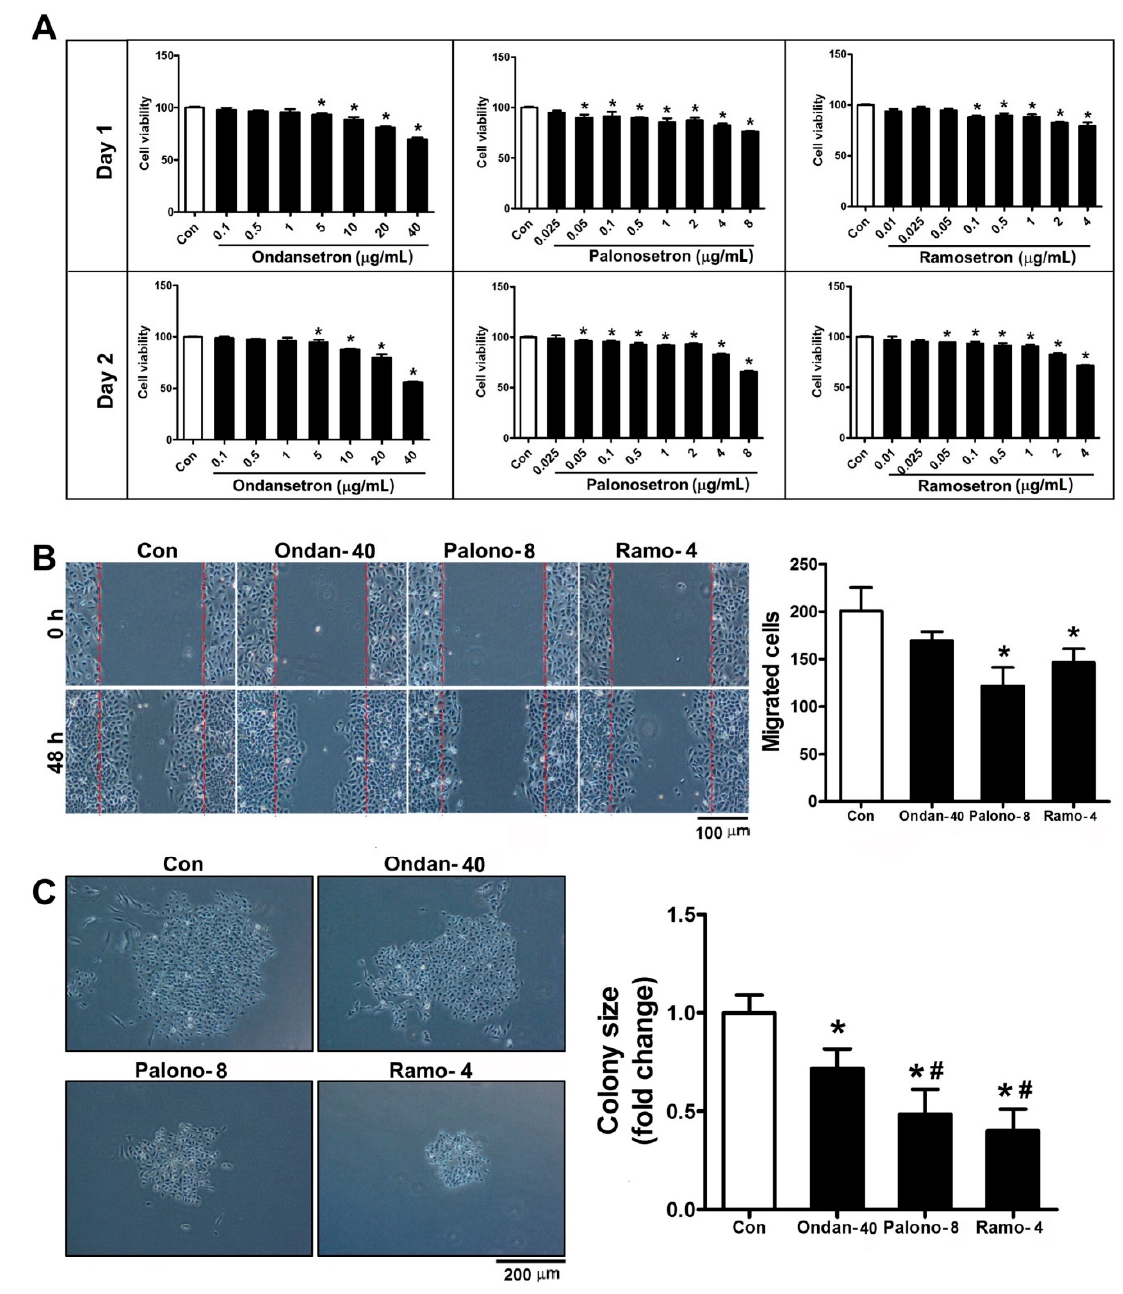
Figure 2. 5-Hydroxytryptamine 3 (5-HT3) receptor antagonists inhibit cell proliferation, migration, and colony formation in lung cancer cells. ( A ) Cell viability was measured by EZ-Cytox Cell Viability Assay Kit after one or two days; n = 8, * p < 0.05 vs. control. ( B) A549 cells were exposed to ondansetron (40 μ g/mL), palonosetron (8 μ g/mL), or ramosetron (4 μ g/mL) for 48 h. Cell migration was examined with the cell scraping assay. Migrated cells were counted at 48 h post-scrape; n = 5, * p < 0.05 vs. control ( C ) Colony size was measured using the Image J software program; * p < 0.05 vs. control, # p < 0.05 vs. ondansetron 40 μ g/mL.